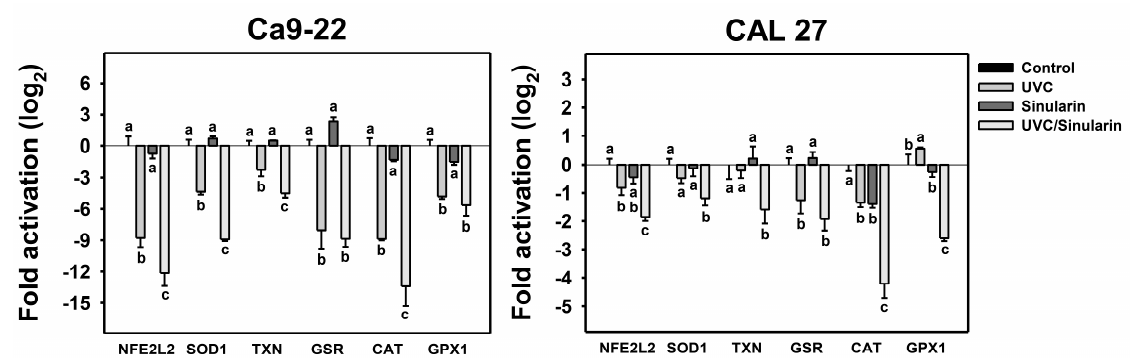
Figure 8. Antioxidant gene expression assay of the UVC and/or sinularin treatments. The fold activation (log 2 ) of a panel of antioxidant genes ( NFE2L2 , SOD1 , TXN , GSR , CAT , and GPX1 ) was performed by qPCR. The UVC and/or sinularin conditions were 12 J/m 2 , 2 μM and 10 J/m 2 , 3 μM for oral cancer cells (Ca9-22, CAL 27) for 48 h, respectively. For the multi-comparisons, the treatments marked without repeated characters (a to c) differ significantly ( p < 0.05). The data were plotted as the mean ± SD ( n = 3).